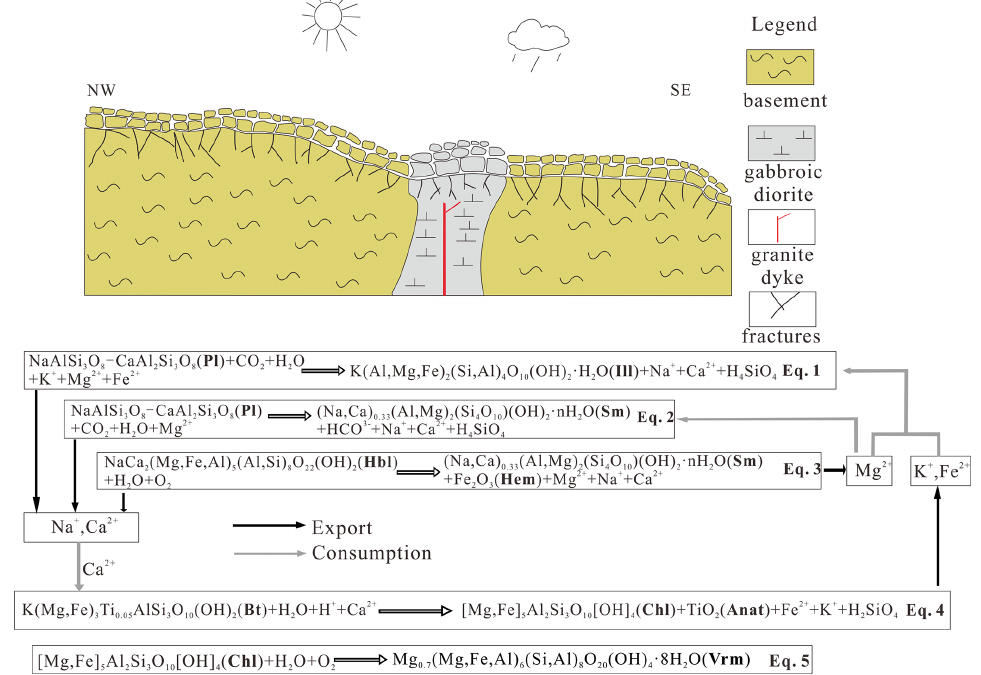
Figure 12. Reconstructed alteration model of the GA1 well in Sprendlinger Horst before volcanic eruption around 300Ma; The abbreviations used in the figure are as follows: Anat – anatase, Bt – biotite, Chl – chlorite, Hbl – hornblende, Hem – hematite, Ill – illite, Pl – plagioclase, Sm – smectite and Vrm – vermiculite.